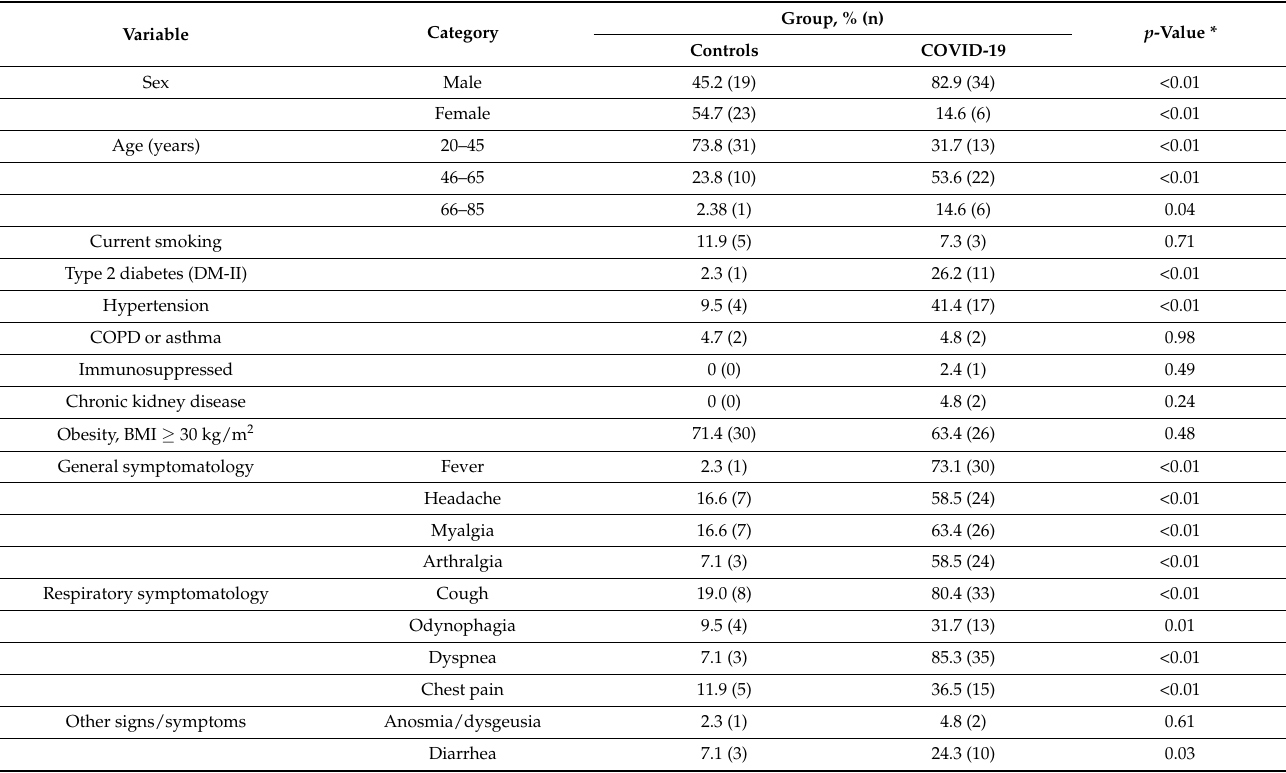
Table 1. Selected sociodemographic characteristics, main comorbidities, and clinical symptoms for patients with severe COVID-19 (n = 41) and healthy controls (n =